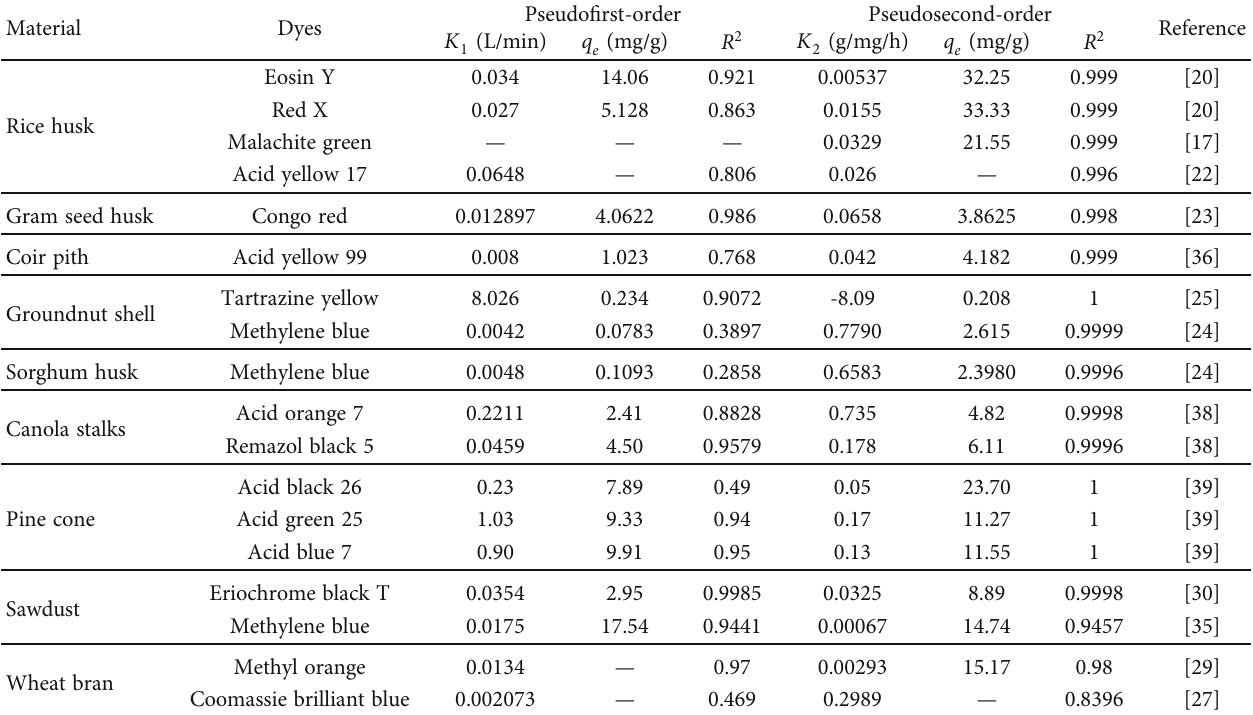
Table 5: Reported parameter values for pseudo fi rst- and pseudosecond-order kinetic models for dye adsorption on various biomass-derived